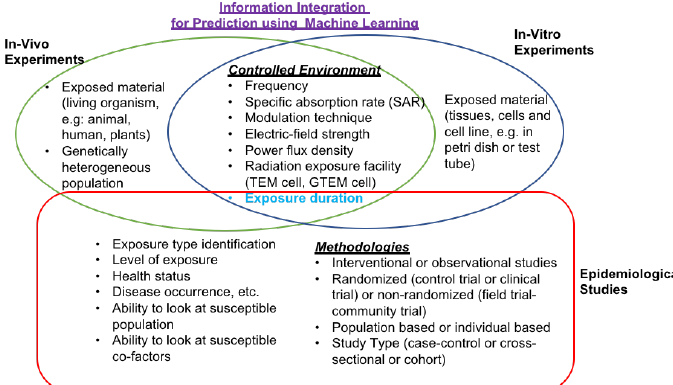
Figure 1. Potential features, attributes, or variables of bioelectromagnetic experiments (in-vitro, in-vivo, and epidemiological studies) that could be utilized in ML